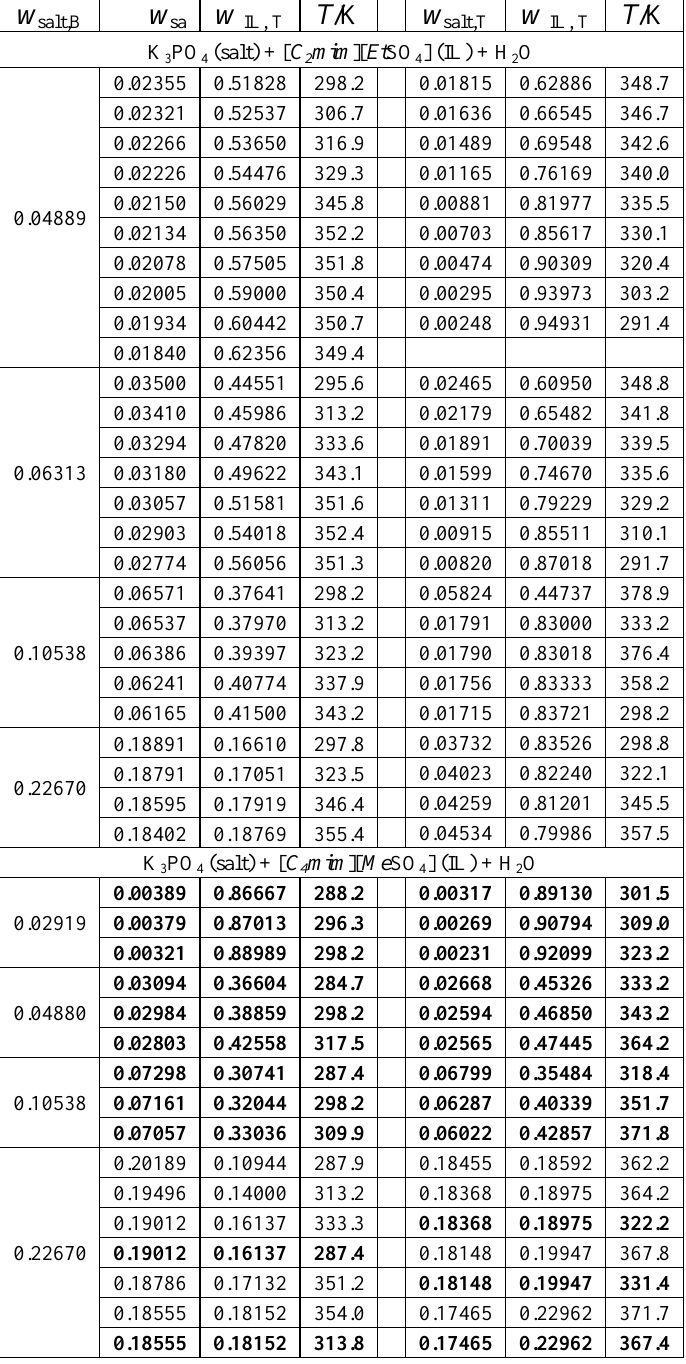
Table 1. Cloud-point temperature, T, as a function of mass fraction, w , of sulfate-based ionic-liquid solutions. The B and T subscripts denote the initial K PO aqueous binary solutions and the ternary solutions. 3 4 Data corresponding to salt precipitation are represented in